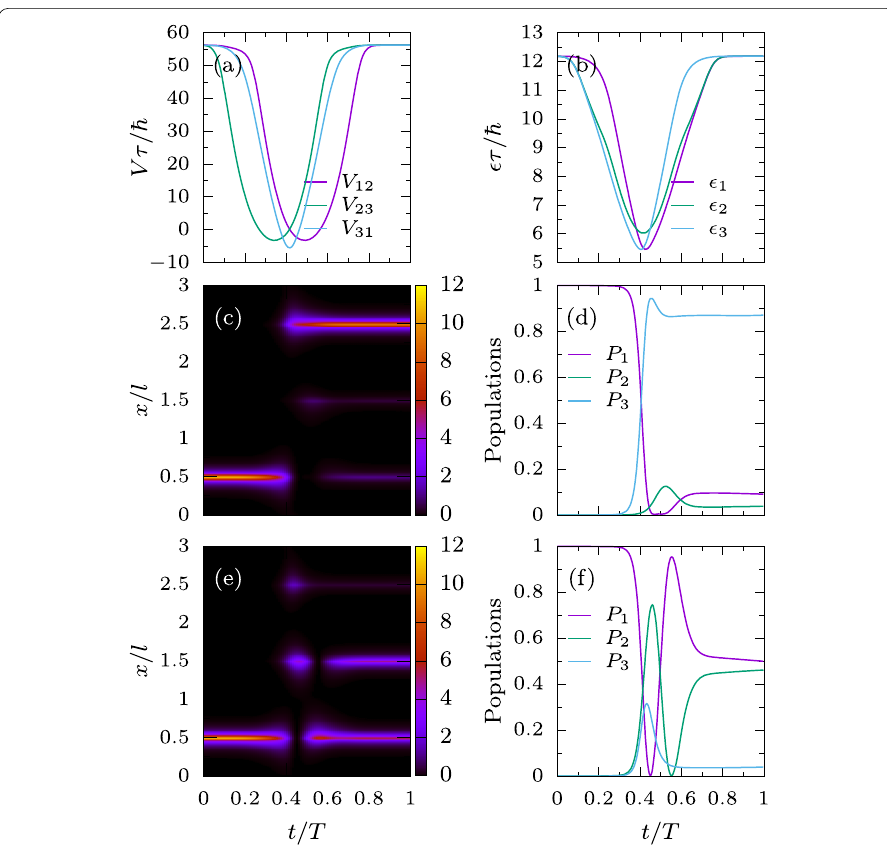
Figure 6 Spatial non-adiabatic transport process in the continuum model. T / τ = 100. (a) , (b) Barrier heights and trap depths obtained by mapping the couplings in Figure 2(a). (c) Evolution of the particle density | ψ ( x , t ) | 2 . (d) Corresponding populations P i = |(cid:10) i | Ψ ( t ) (cid:5)| 2 in each trap and of the target state. (e) , (f)